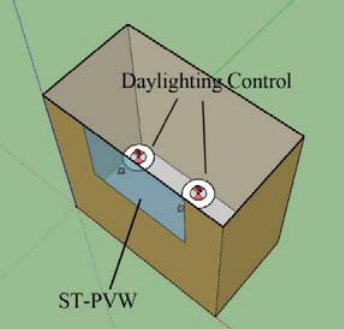
Figure 6. Simulation modeling model diagram (sectional drawing).